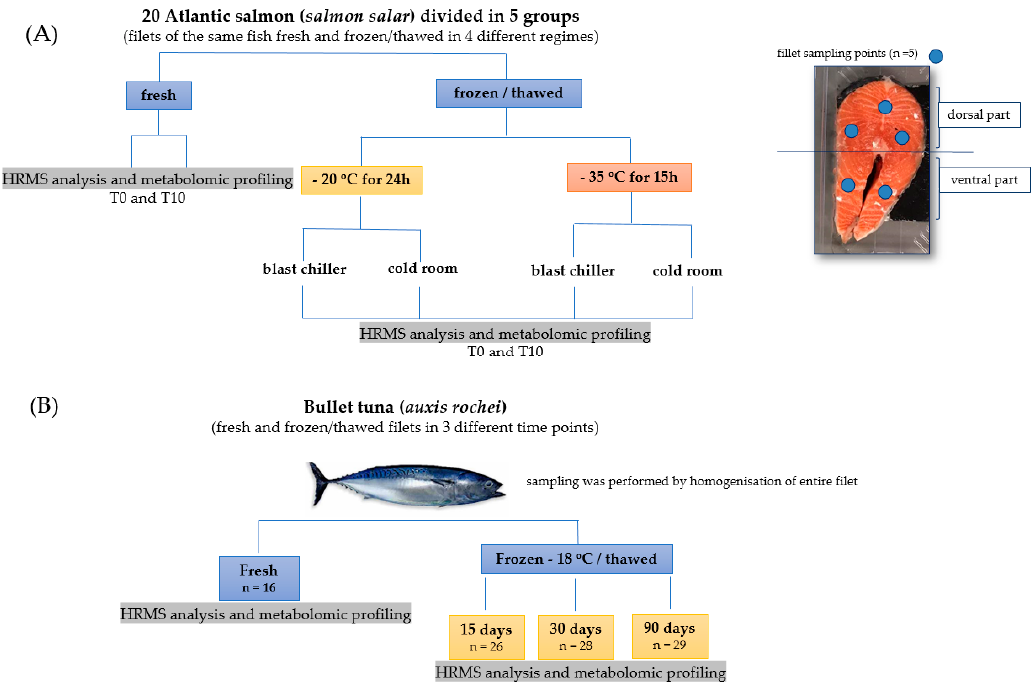
Figure 1. Experimental design adopted in this research for Atlantic salmon ( A ) and bullet tuna ( B ).